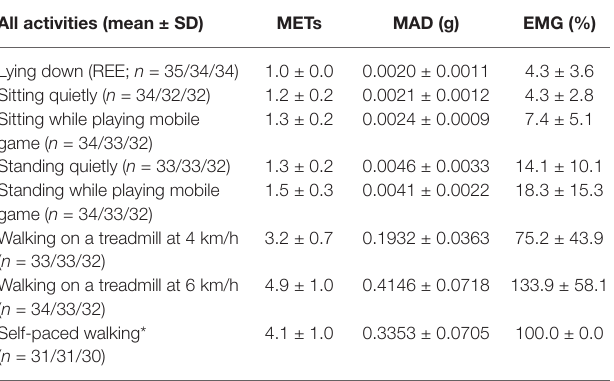
TABLE 2 | The directly measured metabolic equivalent of tasks (METs), mean amplitude deviation (MAD), and mean muscle activity (EMG) in different sedentary and non-sedentary activities.